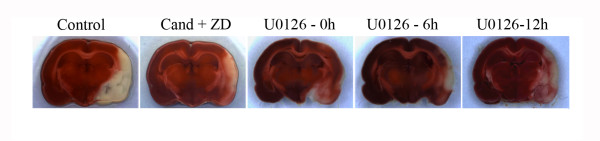
Typical examples of coronal brain sections that show smaller ischemic areas in rats treated with combined Candesartan + ZD1611, U0126 given at 0 and 6 hours after MCAO versus animals treated with vehicle (control). Treatment with U0126 given at 12 hours after MCAO did not decrease the ischemic area.